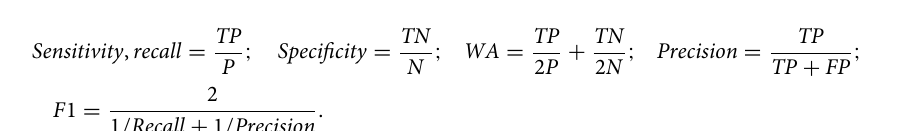
Figure 3. Musician network views for collaboration